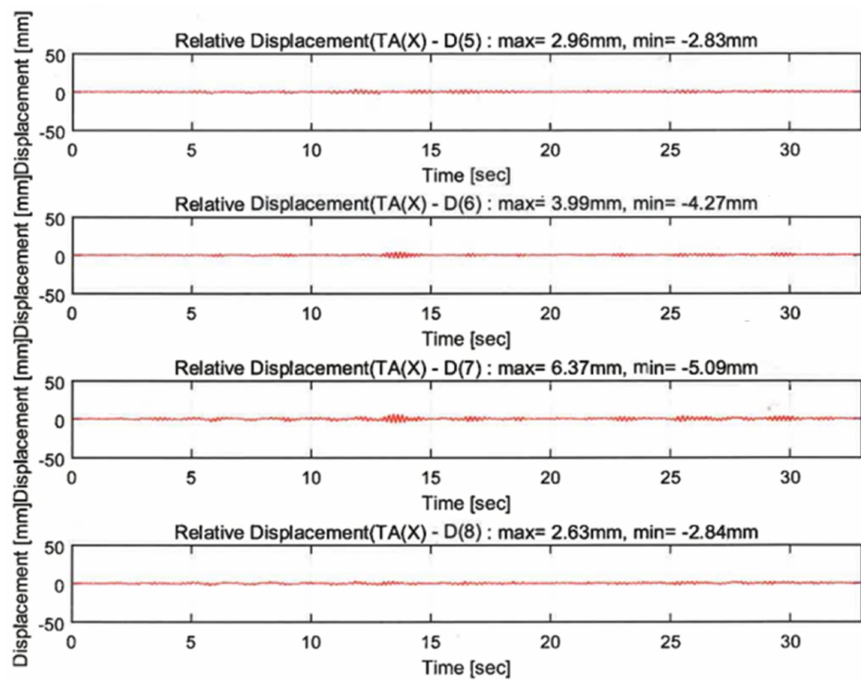
Figure 15. Dynamic responses under random excitation.